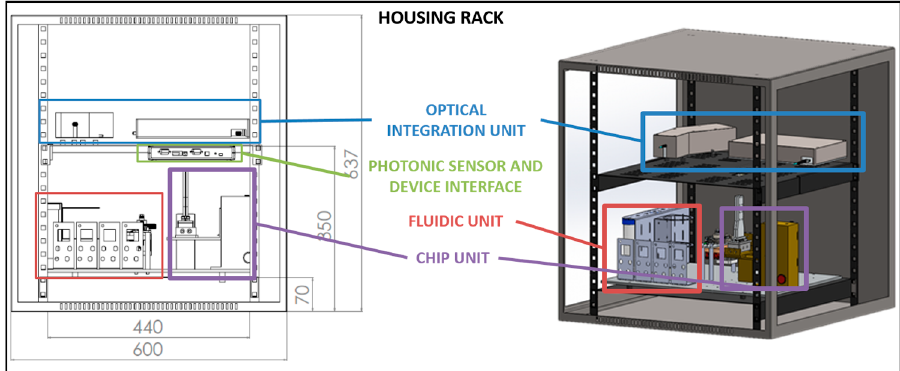
Figure 8. CAD design for the distribution of the different units within the system in several shelves of a commercial rack.